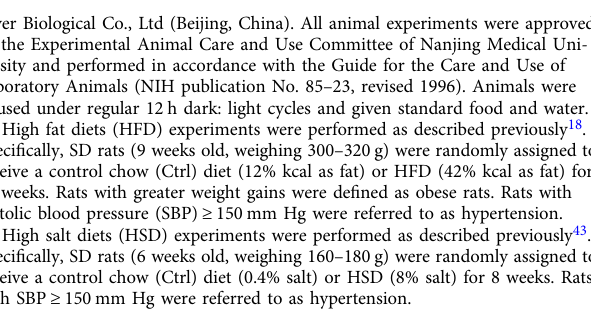
Fig. 7 Schematic illustration of this study. PRAT afferent nerves serve as a pathological node of hypertension that sustains high BP via suppressing CGRP, thereby being a potential therapeutic target to tackle primary